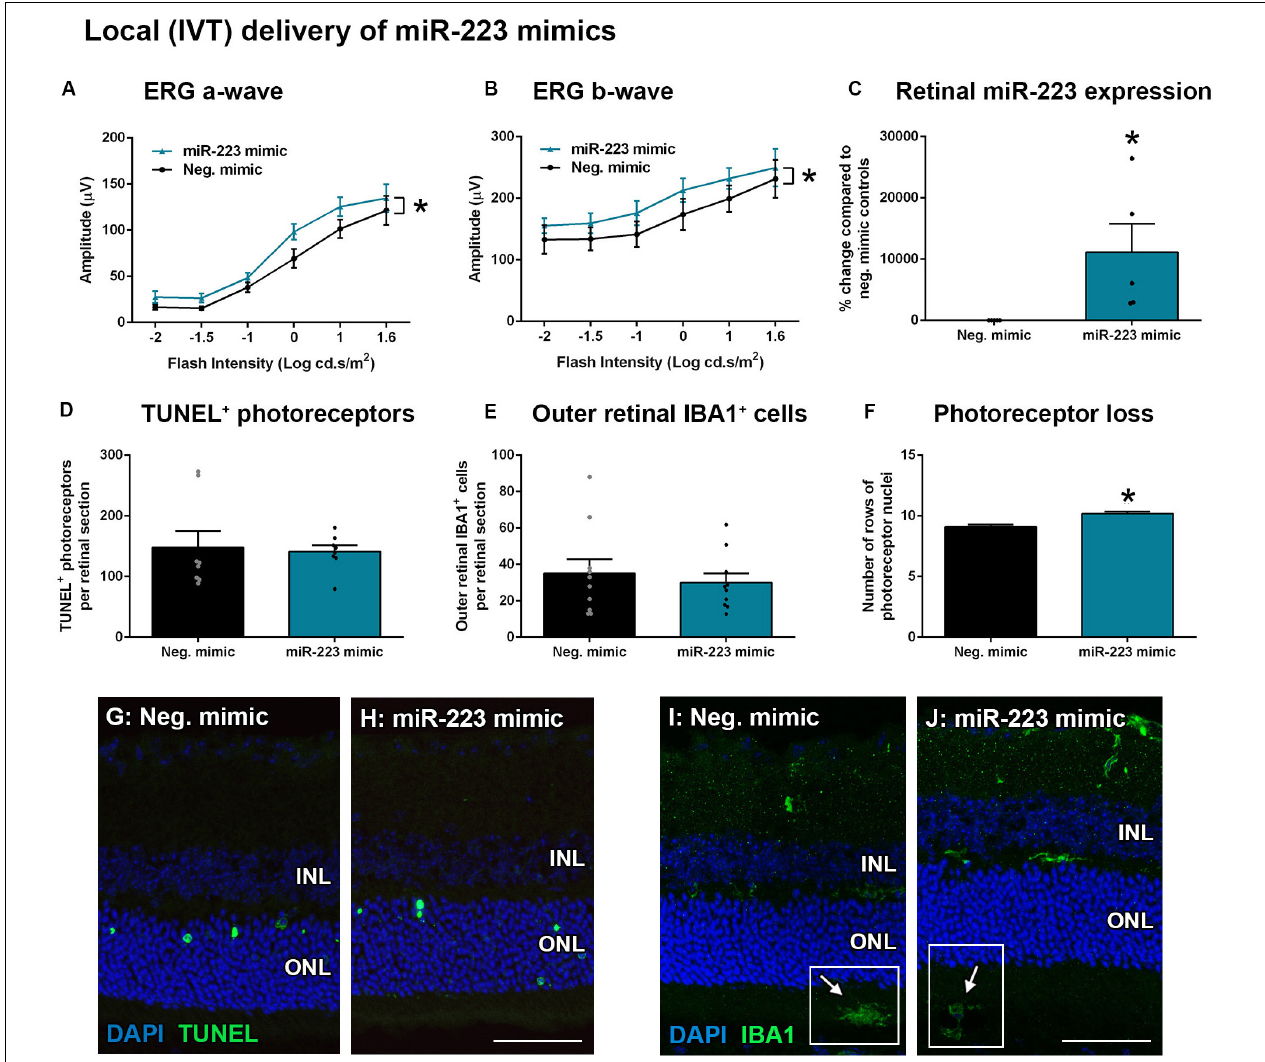
FIGURE 5 | Local intravitreal (IVT) delivery of miR-223 mimics to the retina during 5 days of photo-oxidative damage. (A,B) WT animals injected with miR-223 mimics had a significantly higher a-wave (A) and b-wave (B) than negative controls ( P < 0.05), as assessed by electroretinography (ERG). (C) Retinal expression of miR-223 was significantly higher at 5 days after mimics were intravitreally injected ( P < 0.05). (D,E) There was no significant difference in TUNEL + (D) or IBA1 + cells (E) in the outer retina between groups ( P > 0.05). (F) Retinas injected with miR-223 mimics had a significantly higher number of photoreceptor rows compared to controls ( P < 0.05). (G,H) Representative images depicting TUNEL + photoreceptors (green). (I,J) Representative images depicting IBA1 immunohistochemistry (green), with arrows pointing towards IBA1 + cells in the subretinal space (white boxes). INL, inner nuclear layer; ONL, outer nuclear layer. Scale bar is 50 µ m. Sample size is N = 4–5. *Denotes significance ( P <